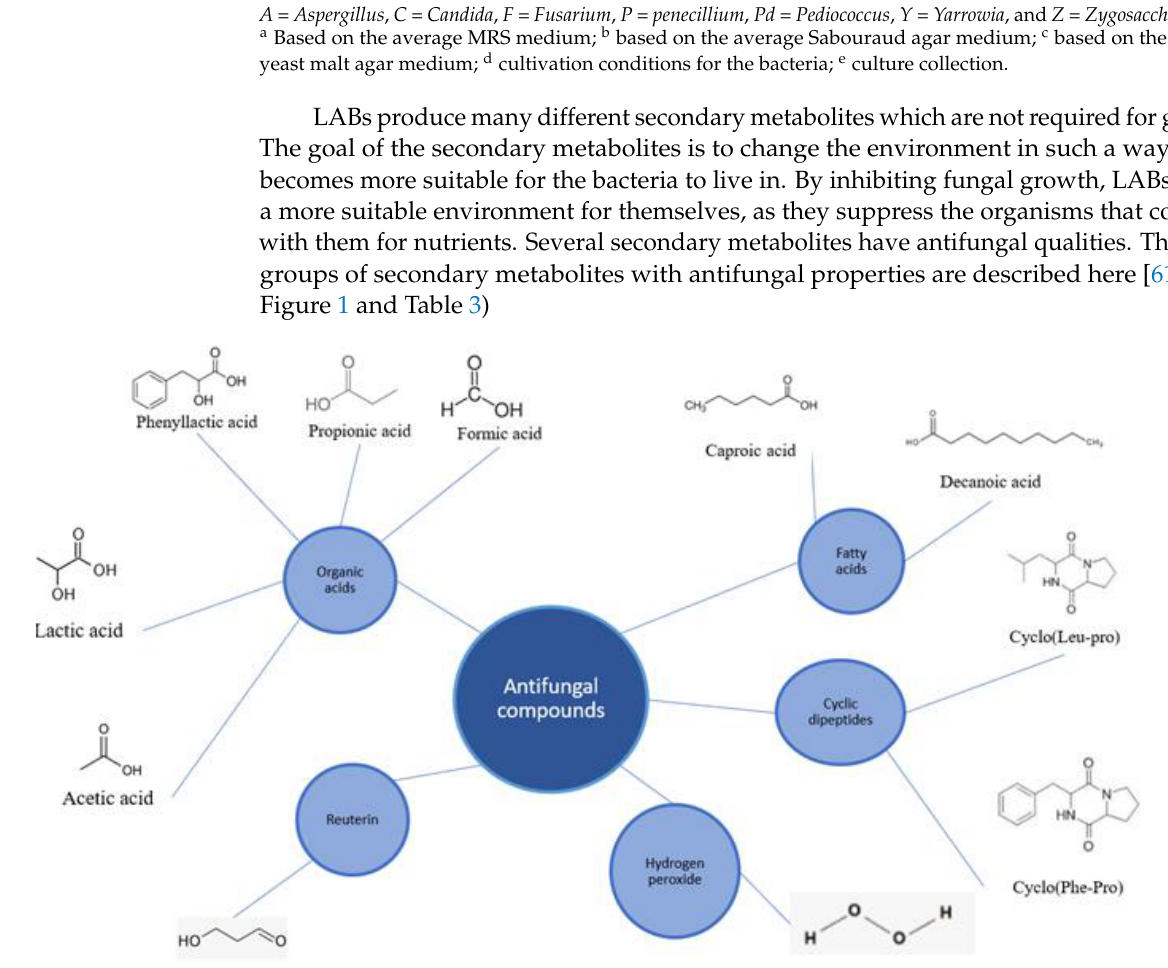
Figure 1. Chemical structure of some antifungal compounds produced by LABs. Table 3. Minimum inhibitory concentration (MIC) of several antifungal compounds based on Ref- erence.